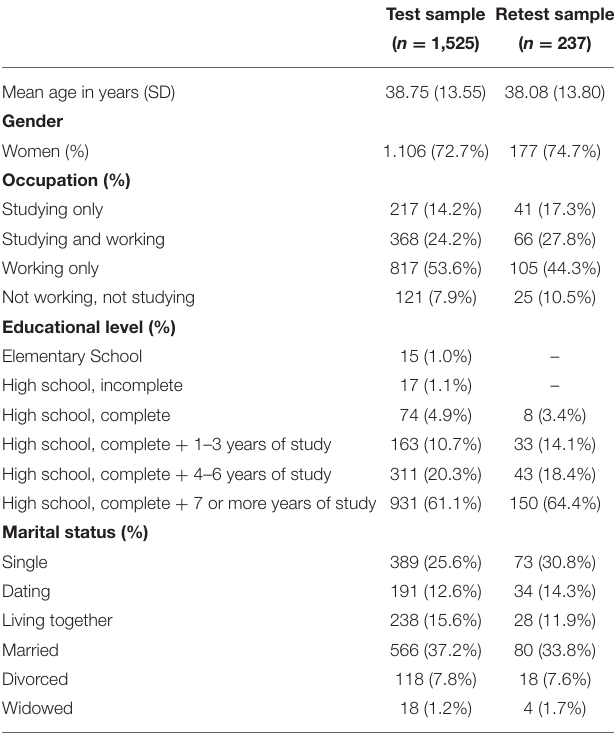
TABLE 1 | Descriptive statistics of sociodemographic